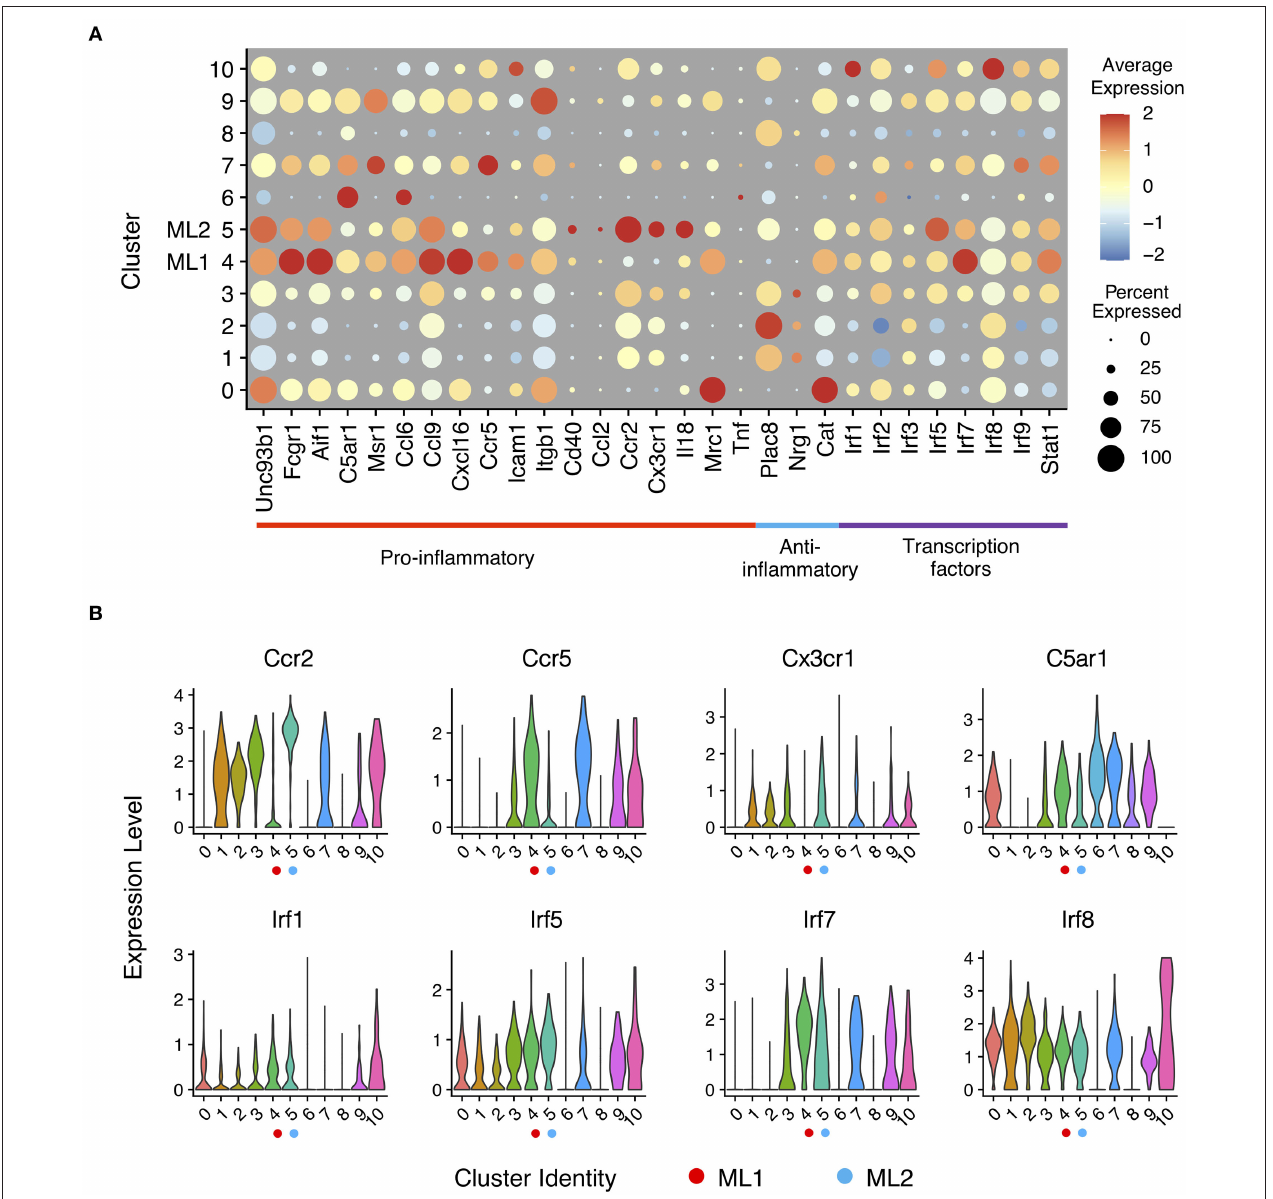
FIGURE 2 | Expression profiles of inflammatory marker genes in monocytes response to LPS challenges. (A) Gene expression levels of pro- and anti-inflammatory marker genes and interferon-regulatory factor genes related to innate immune regulation in a dot plot. Sizes of dots are proportional to percentages of expressed cells in each cluster. (B) Relative expression levels of selected gene from (A) in violin plots showing expression levels of genes by clusters (bottom).